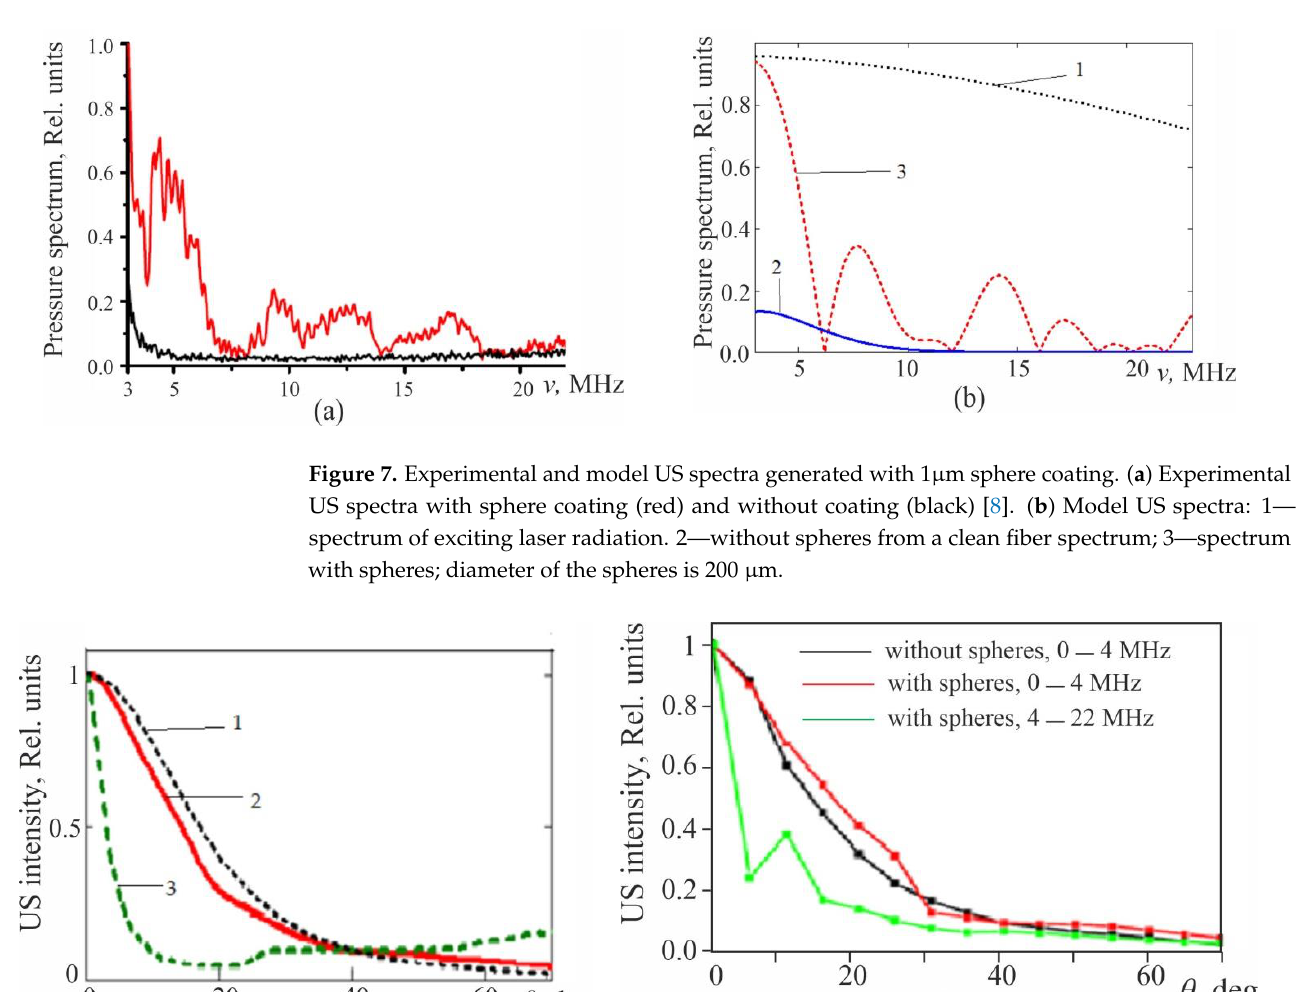
Figure 8. Model and experimental US intensity generated with 1 µ m sphere coating versus angle θ . ( a ) Model US intensity versus angle θ for various spectral regions (1–3). ( b ) Experimental US intensity versus angle θ for various spectral regions [8].